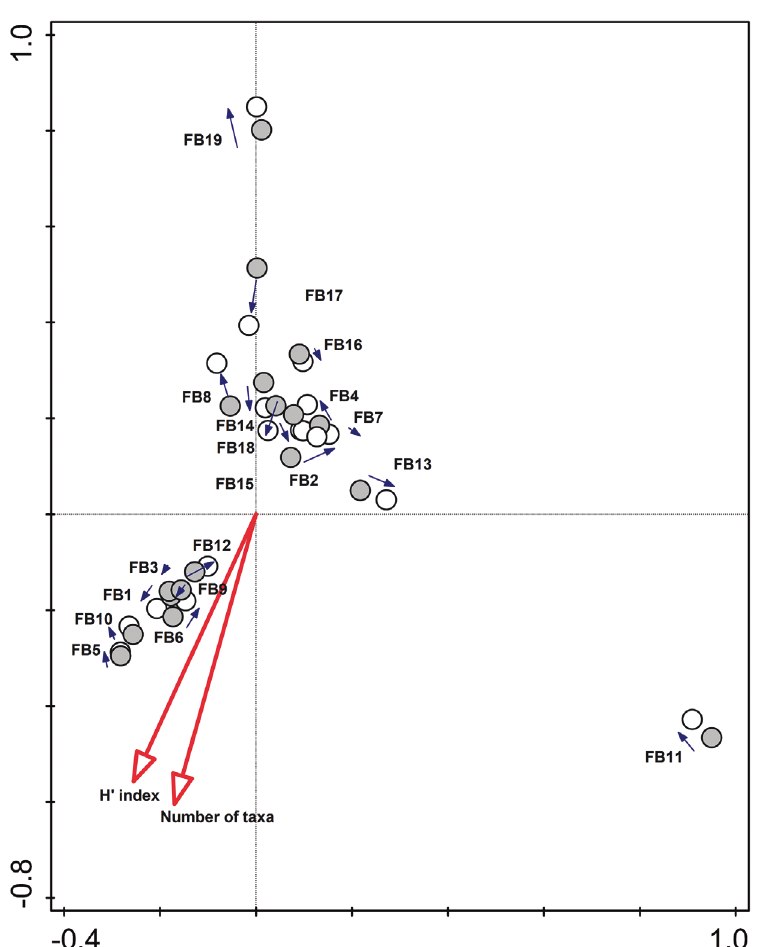
Figure 4. Ordination (CCA) diagram of average change in the studied flowerbeds. Grey symbols repre- sent the initial state of assemblages and white symbols represent the recent state. Distances between the corresponding spots indicate the rate and direction of change.